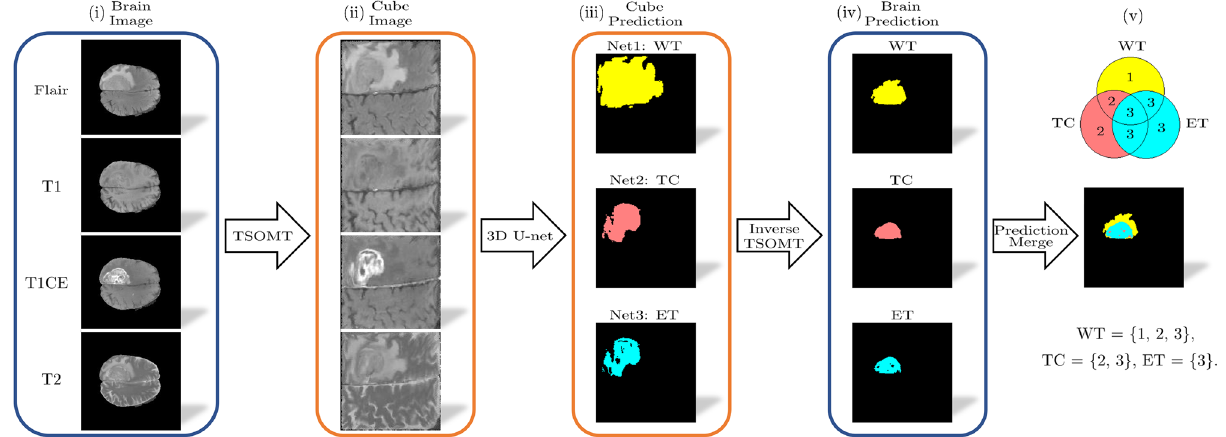
Figure 5. Flowchart of the segmentation maps: (i) input the brain image, (ii) utilize the TSOMT method to transform the brains into cubes, (iii) predict the WT (yellow), TC (red), and ET (blue) through 3D U-Nets Net 1, Net 2, and Net 3, respectively, (iv) reverse the cube prediction back to a brain prediction via the inverse TSOMT method, and (v) merge the WT, TC, and